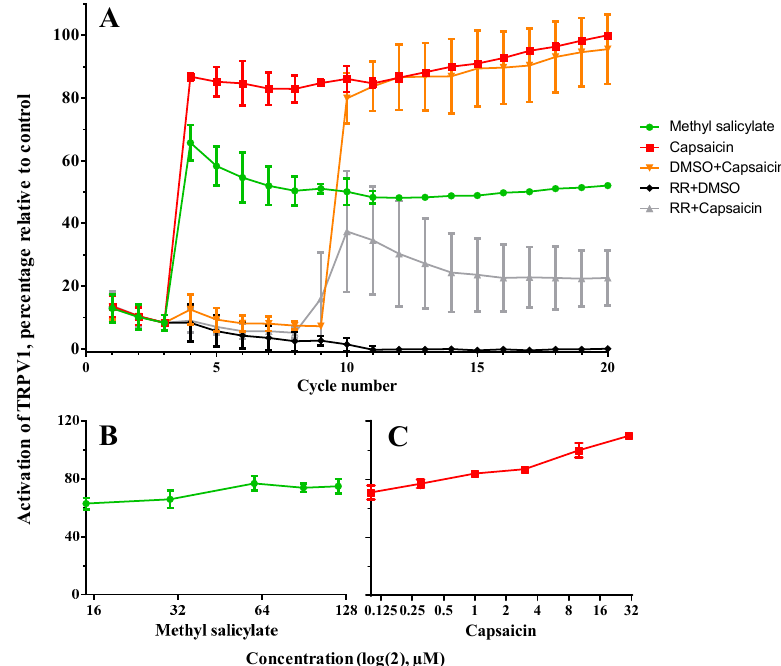
Figure 3. Functional analysis of transient receptor potential cation channel 1 (TRPV1) in vitro and calibration of its agonists. ( A ) TRPV1 activation dynamics were determined by performing fluorescence time-course assays in cells stably expressing TRPV1 after treatment with agonists (30 μ M of methyl salicylate and 10 μ M of capsaicin) and antagonist (ruthenium red, RR). TRPV1 activation was observed once agonists were added, while the inoculation of the antagonist attenuated this response. ( B , C ) Additionally, concentrations of agonists lower and higher than those to be tested from produced nanofibers under these experimental conditions were assayed in order to better assess the functionality of the compounds when they were encapsulated. For all analysis, the level of activation is calculated as the percentage relative to the highest value from the time-course in cells treated with 10 µ M of capsaicin, and relative to the lowest value from RR treatment as the baseline.